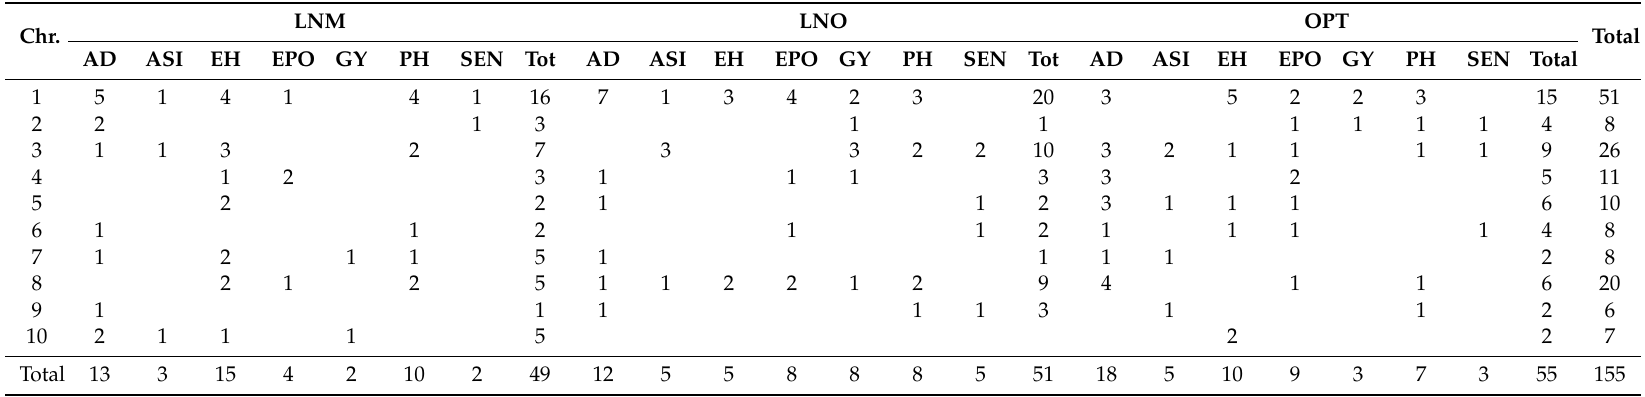
Table 2. Number of QTL detected for grain yield (GY), anthesis date (AD), anthesis-silking interval (ASI), plant height (PH), ear height (EH), ear position (EPO), and leaf senescence (SEN) under optimum and low-nitrogen stress in main rainy season (LNM) and o ff -season (LNO), across the ten chromosomes.